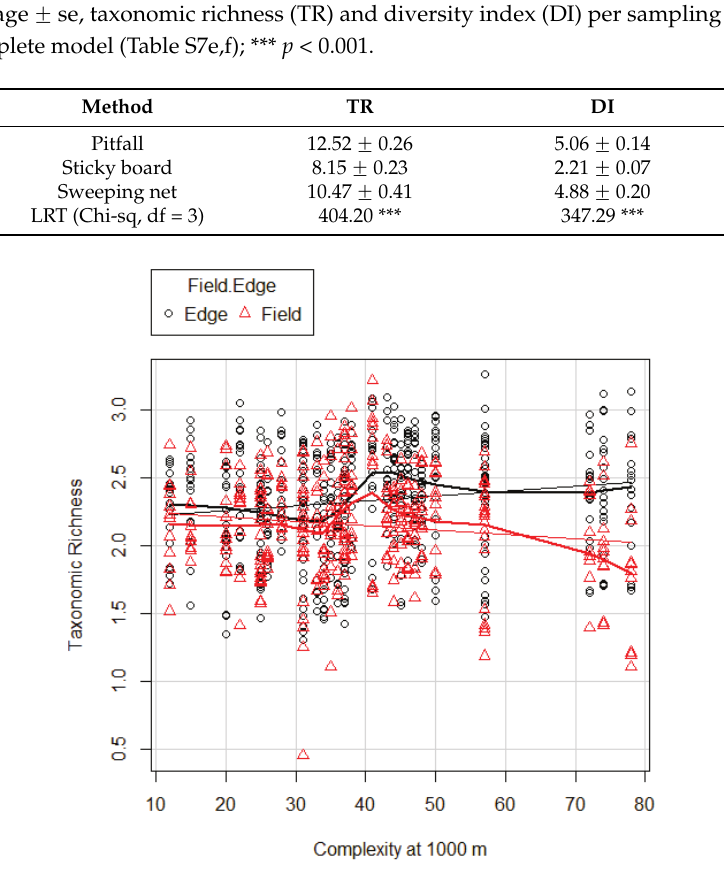
Figure 2. Taxonomic richness predicted by the best model for TR, Model 1000 (Table 8) in FE and FI as related to complexity at 1000 m. Thin line: linear regression line; thick line: non-linear regression line (LOESS curve). The y-axis is ln(TR).